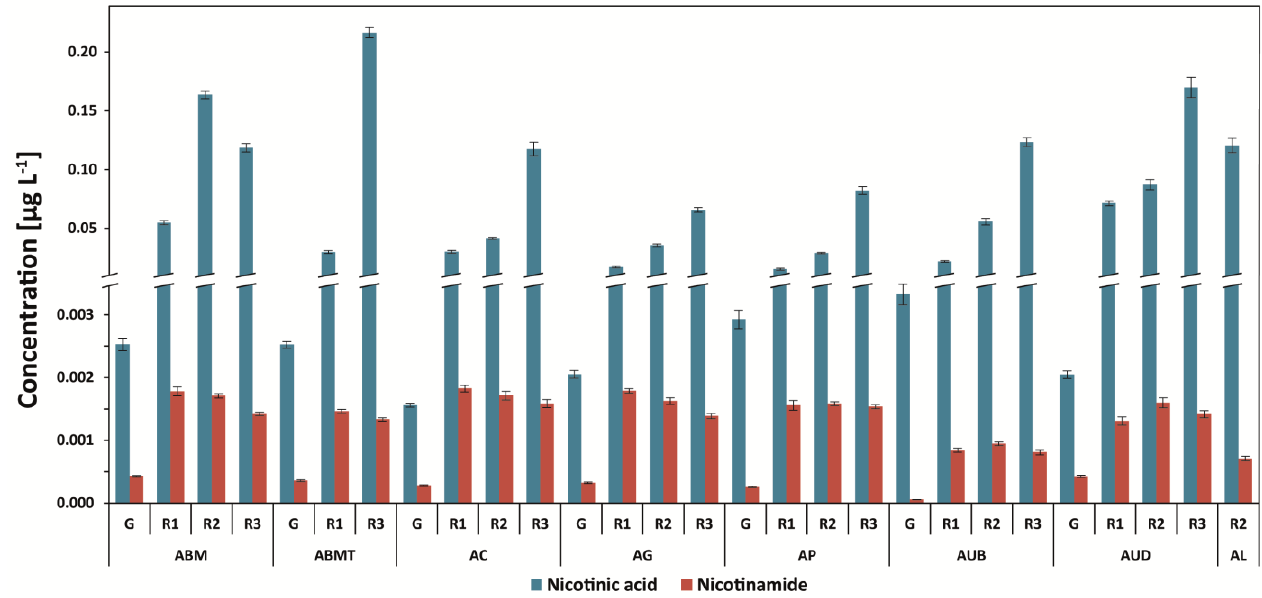
Figure 5. Nicotinic acid and nicotinamide content in Arabica coffee brews. Legend—Figure 1 cap- ture.